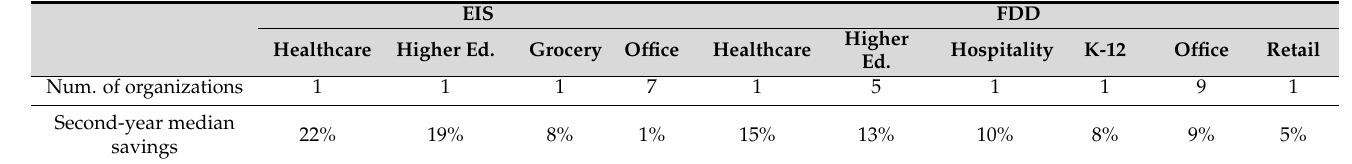
Table 3. The second-year energy savings distributions by building sector. EIS FDD Healthcare Higher Ed.